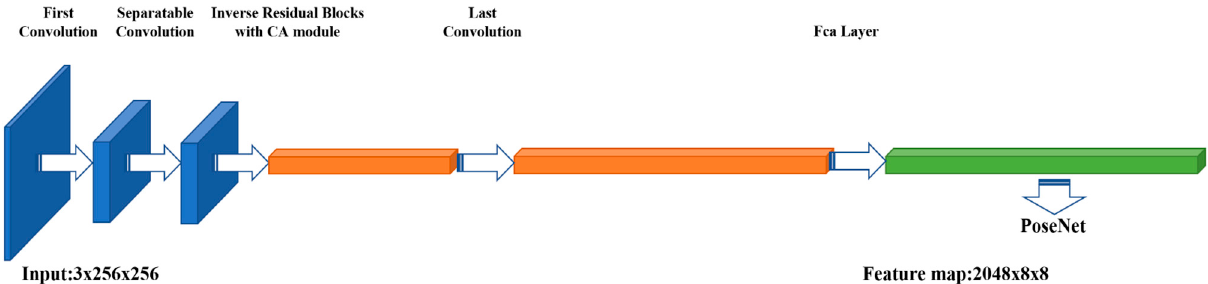
Figure 4. Feature extractor part of the network. Each cube represents the output tensor of a certain layer; the left and right thickness represent the number of channels, and the other two dimensions are its 2D dimensions. Orange and green represent the tensor processed by the coordinate and multispectral attention mechanisms, respectively. Table 1. The structure of feature extraction network in InterNet+.